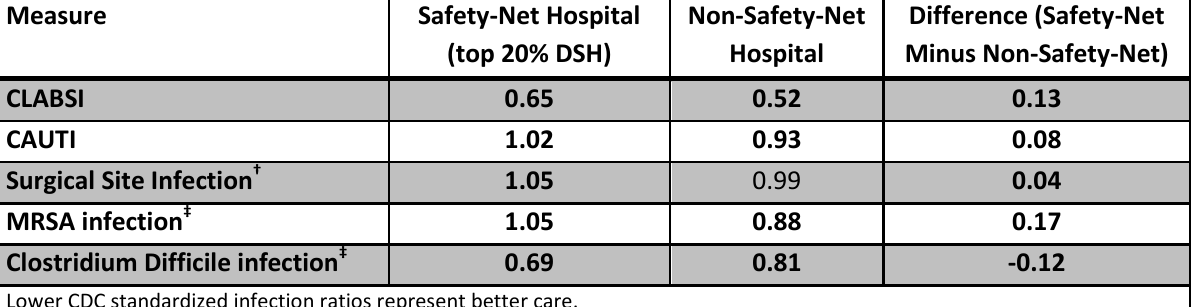
Table 6.8: Hospital Social Risk and CDC Infection Ratios